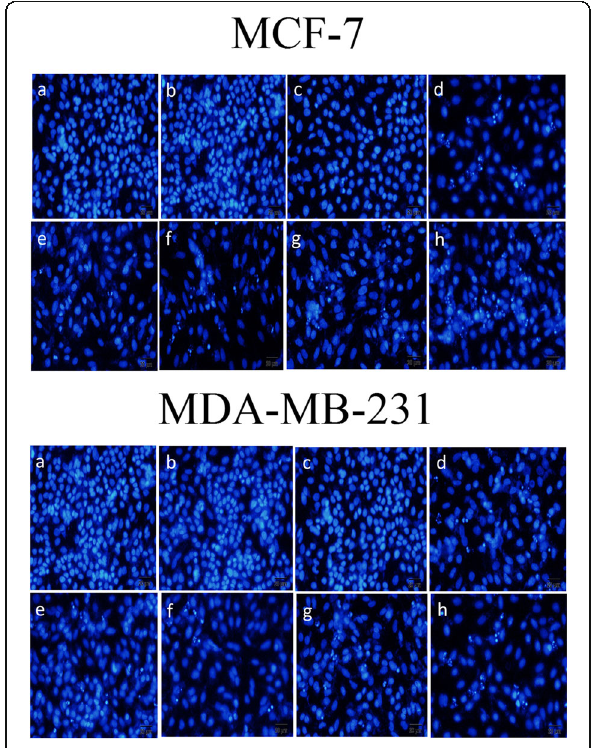
Fig. 8 Apoptosis assay using DAPI staining for MCF-7 or MDA-MB- 231 cells, images captured using an inverted microscope. The untreated cells as the negative control ( a ), cells treated with laser (75 J/cm 2 ) as positive control ( b ) cells treated with Au@SiO 2 nanoparticles (NP ( c ), cells treated with laser (75 J/cm 2 ) and Au@SiO 2 nanoparticles (NP) ( d ), cells treated with MTX without laser irradiation ( e ), cells treated with MTX and laser irradiation ( f ), cells treated with MTX-FA-loaded Au@SiO 2 nanoparticles (NPD) without laser exposure ( g ), and cells treated with MTX-FA-loaded Au@SiO 2 nanoparticles (NPD) with Laser exposure ( h